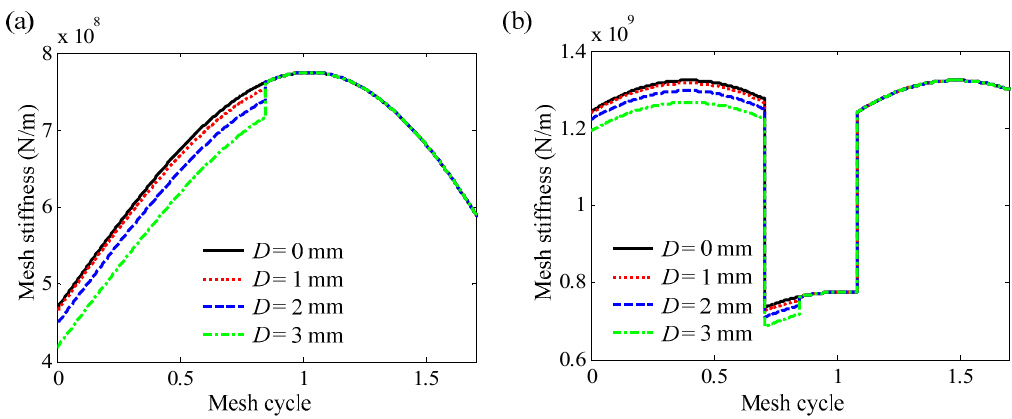
Figure 7. Effects of surface crack depth on meshing stiffness: ( a ) single ‐ tooth pair, ( b ) double ‐ tooth pairs.